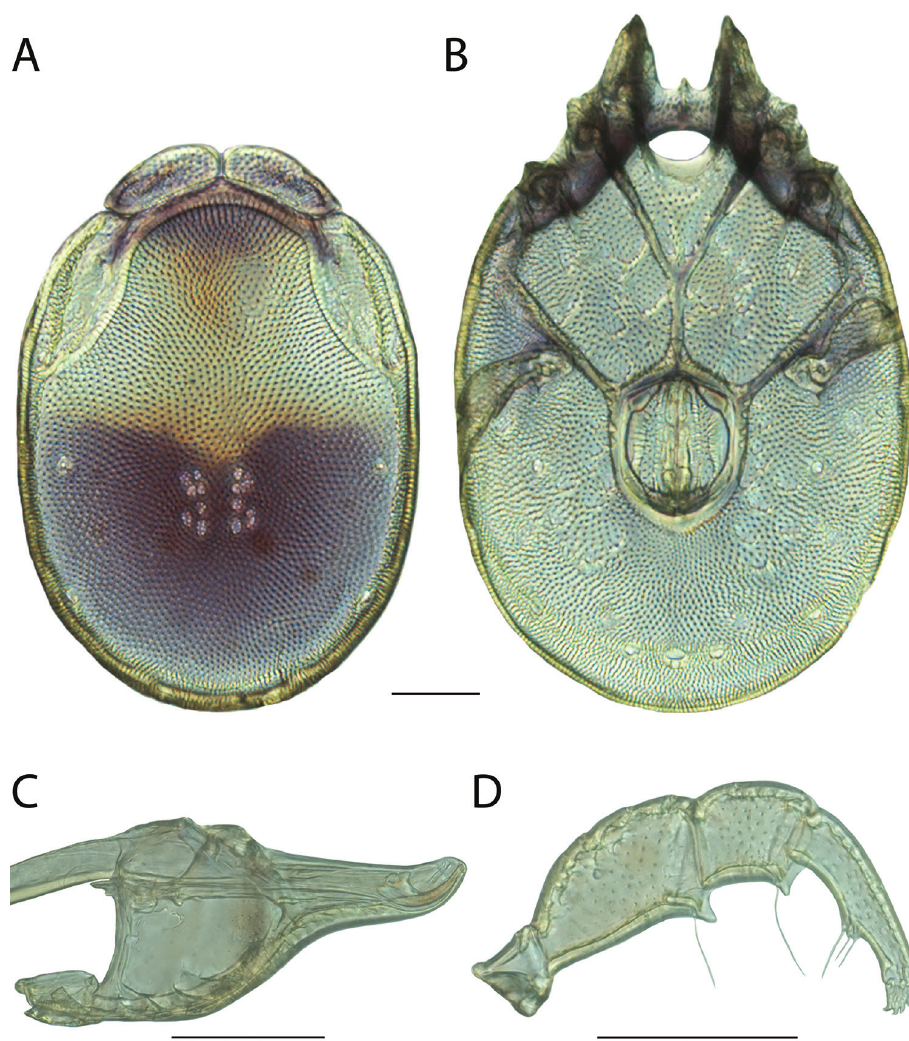
Figure 136. Torrenticola magnexa male: A dorsal plates B venter (legs removed) C subcapitulum D pe- dipalp (setae not accurately depicted). Scale = 100